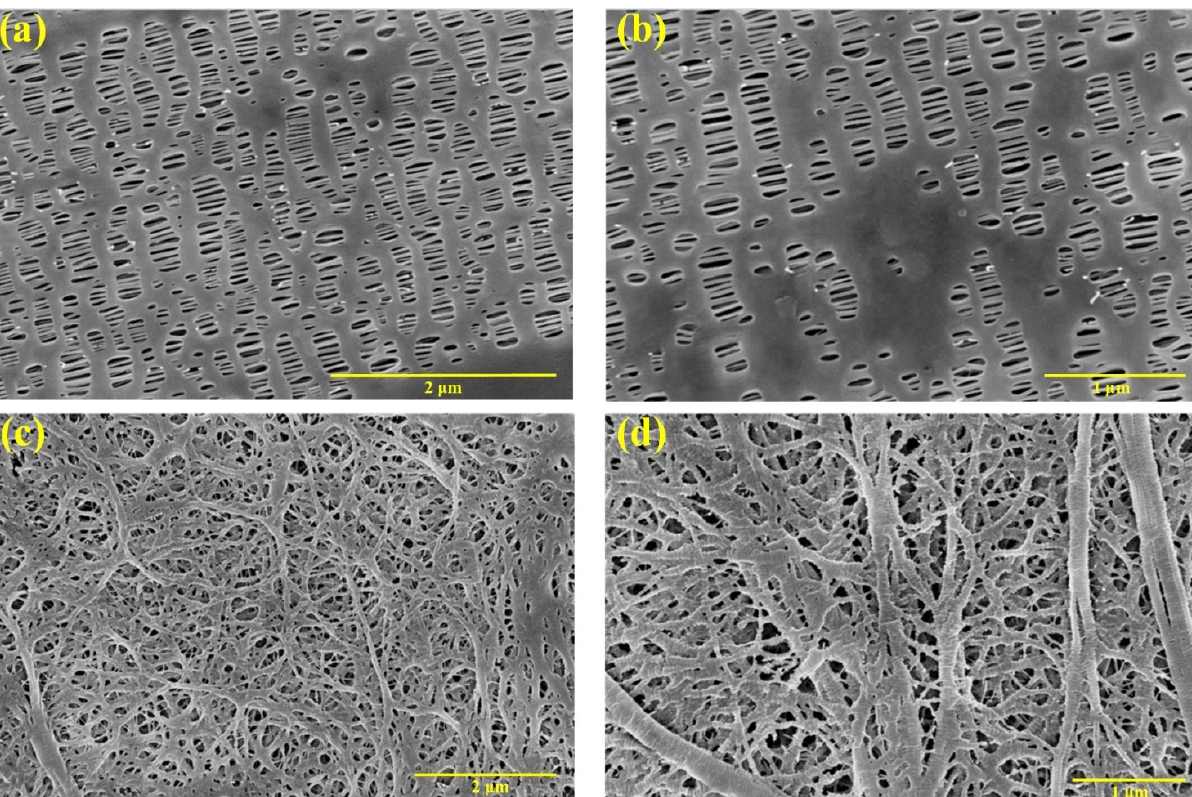
Figure 1. Microstructures of in-plane view of PP/PE/PP and PE separators: ( a ) PP/PE/PP (8 × 10 4 times); ( b ) PP/PE/PP (1 × 10 5 times); ( c ) PE (5 × 10 4 times); ( d ) PE (8 × 10 4 times). The actual working environment of LIBs is between positive and negative electrodes.